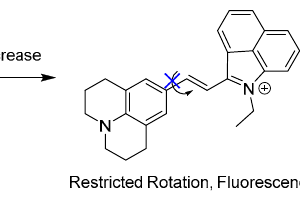
Figure 22. NIR fluorescence increase mechanism of MN − V with the increase in viscosity [84]. In addition, by modified a BODIPY fluorophore with an endoplasmic reticulum tar- getable sulfonamide group via click reaction, Xiao’s group [85] reported a viscosity sensitive probe L − Vis − 1 for tracking endoplasmic reticulum viscosity changes in endoplasmic retic- ulum (Figure 23). L − Vis − 1 showed 26 − fold fluorescence enhancement at 515 nm